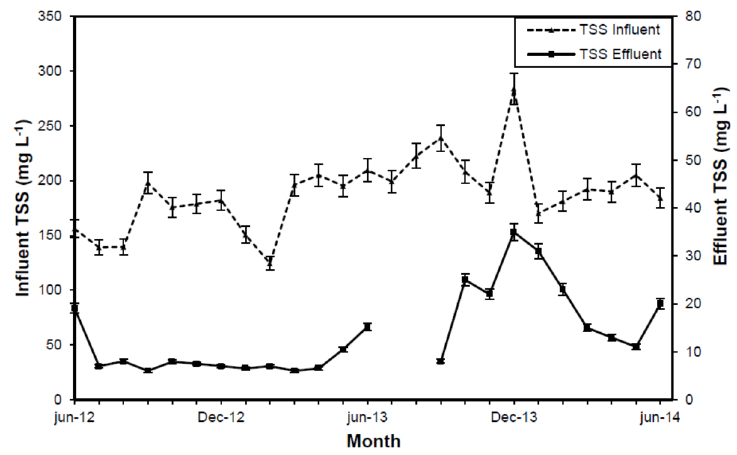
Figure 3. Total suspended solids (TSS) concentrations at the influent and the effluent of the studied horizontal subsurface flow constructed wetland.